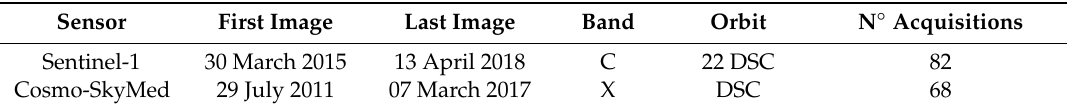
Table 1. Sentinel-1 data employed for study, with first and last image of each dataset, band, orbit, and number of